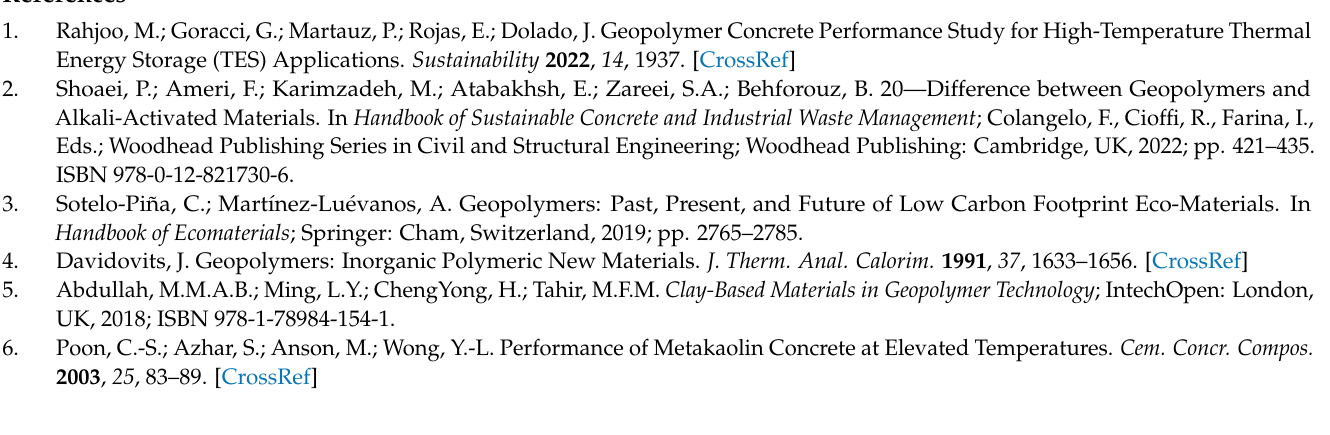
Figure 7. Bulk Density and apparent porosity of geopolymer samples.